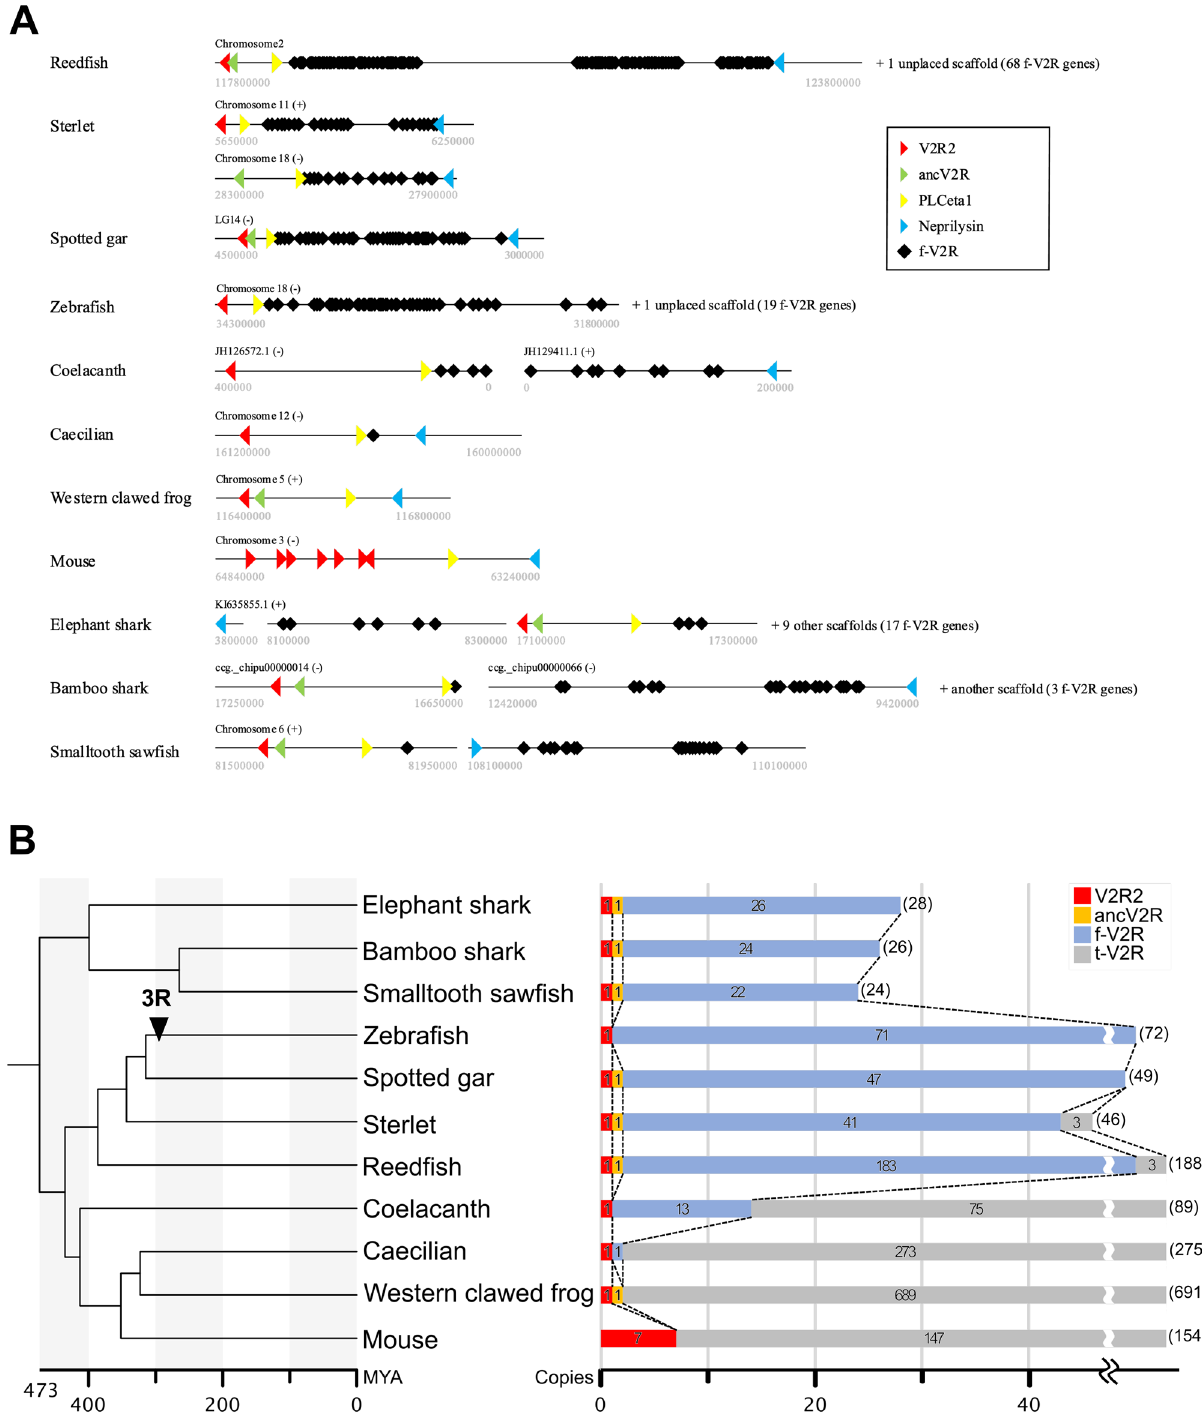
Figure 2. ( A ) Synteny relationships for the f- V2R clusters among basal ray-finned fish (reedfish, sterlet, spotted gar), teleost fish (zebrafish), lobe-finned fish (coelacanth), tetrapods (caecilian, western clawed frog, mouse), and cartilaginous fish (elephant shark, bamboo shark, and smalltooth sawfish), respectively. Triangles in yellow, blue, red, and green indicate two landmark genes ( PLC eta1 , neprilysin ), V2R2 , and ancV2R , respectively. Black squares indicate f- V2R s. Indicated at the upper-left of each line were several chromosomes or scaffolds and its directions. Indicated below the ends of the line are the start and end of the cluster regions. Unplaced scaffolds are not shown in this figure. Note that f- V2R s were flanked by two landmark genes and that V2R2 s and ancV2R s were located in tandem close to the clusters. No t- V2R s were observed in these cluster regions. In the elephant shark, some f- V2R s are located outside the cluster because the cluster regions were not properly assembled. ( B ) Changes in the number of V2R s during vertebrate evolution. The phylogenetic tree with timescale for 11 representative vertebrates (left) and the number of V2R s in these species (right) are shown. The timing of teleost-specific third round whole genome duplication (3R) is indicated by arrow. The color and number on the bar graph indicate the clade and copy number, respectively. The total copy number of V2R s is shown in parentheses on the right of the graph. MYA: million years